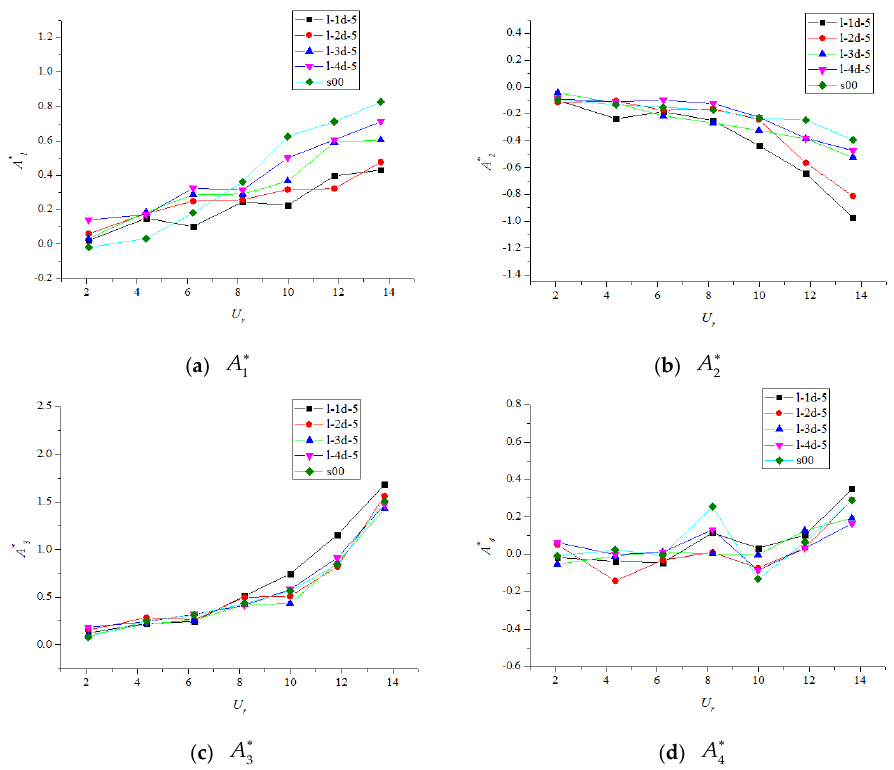
Figure 9. ( a – d ) Flutter derivatives A ∗